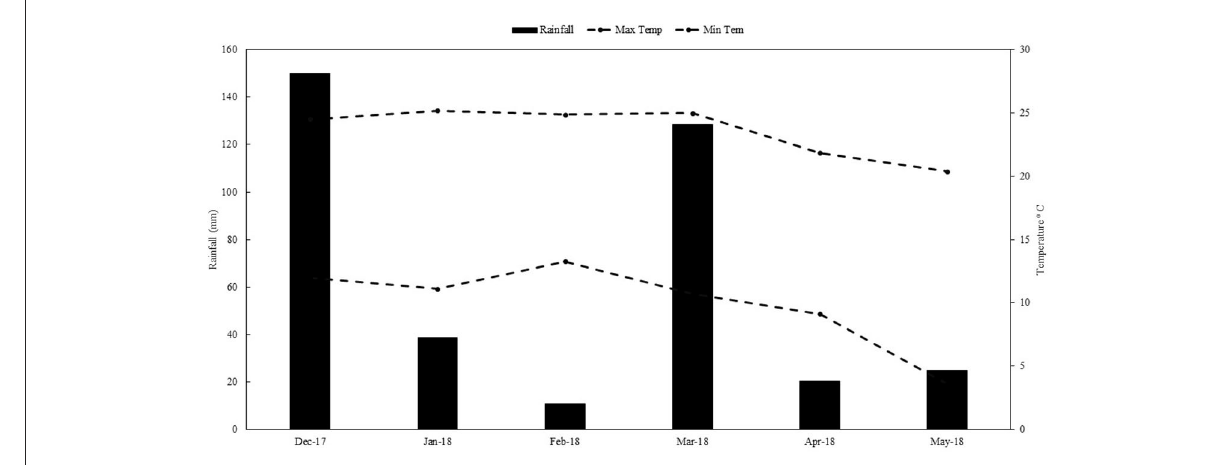
FIGURE1 Climate data of the study site during the planting season.